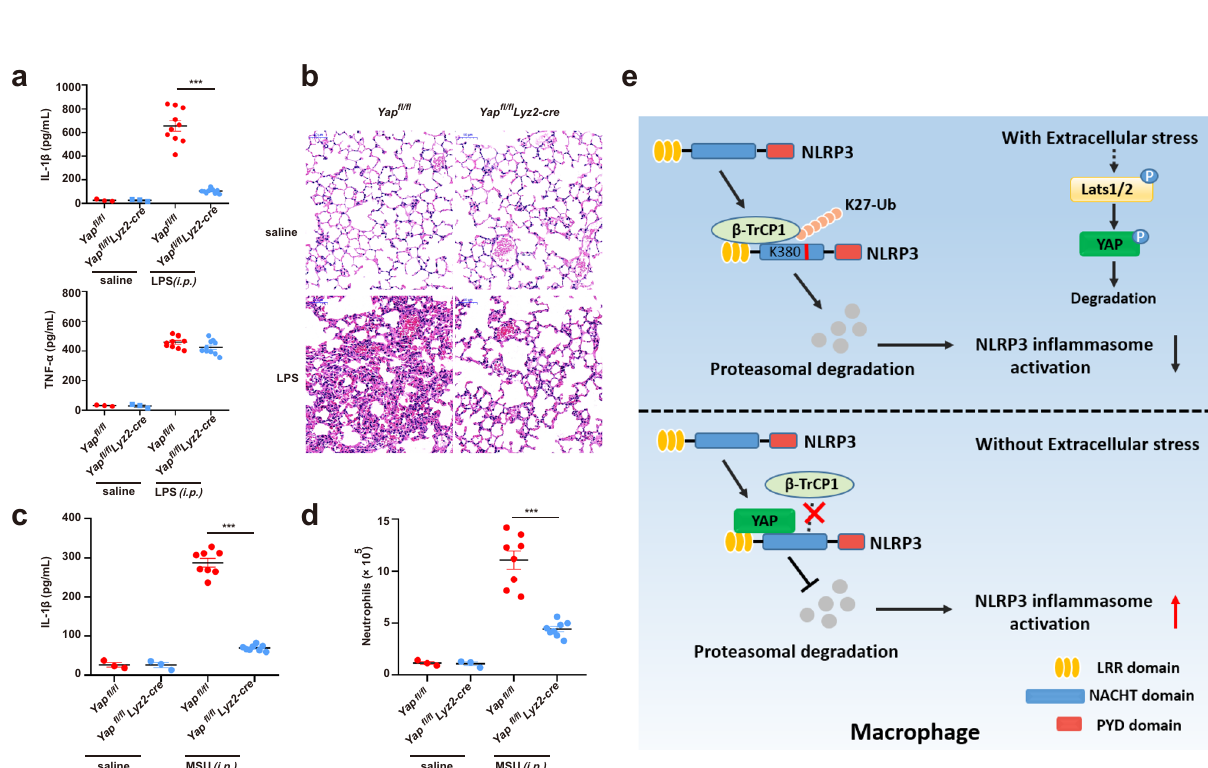
Fig. 8 YAP promotes NLRP3 in fl ammasome activation in vivo. a , b Yap fl / fl lyz2-Cre or Yap fl / fl mice were intraperitoneal injected 20 mg/kg LPS for 6 h, ELISA analysis of serum levels of IL-1 β and TNF- α ( a ), H&E staining of lung tissue sections(b) Scale bars, 50 μ m (mean ± SEM, two-way ANOVA with Bonferroni test, Yap fl / fl lyz2-Cre vs. Yap fl / fl , *** P < 0.0001, n = 10 biologically independent mice). c , d Yap fl / fl lyz2-Cre or Yap fl / fl mice were intraperitoneally injected with 1 mg monosodium urate for 6 h, ELISA analysis of IL-1 β ( c ) and quanti fi cation of neutrophils ( d ) in the peritoneal cavity fl uid (mean ± SEM, two-way ANOVA with Bonferroni test, Yap fl / fl lyz2-Cre vs. Yap fl / fl , *** P < 0.0001 ( c ), *** P < 0.0001 ( d ) in sequence, n = 8 biologically independent mice). e The model of YAP in NLRP3 in fl ammasome activation. YAP maintains the stability of NLRP3 by blocking/masking the interaction between NLRP3 and the E3 ligase β -TrCP1, which promotes the proteasomal degradation of NLRP3 via K27-linked ubiquitination at lys380. Cellular nutrient/density status, activating the Hippo-YAP pathway, impairs NLRP3 in fl ammasome activation in a YAP-dependent manner. Source data are provided as a Source Data fi